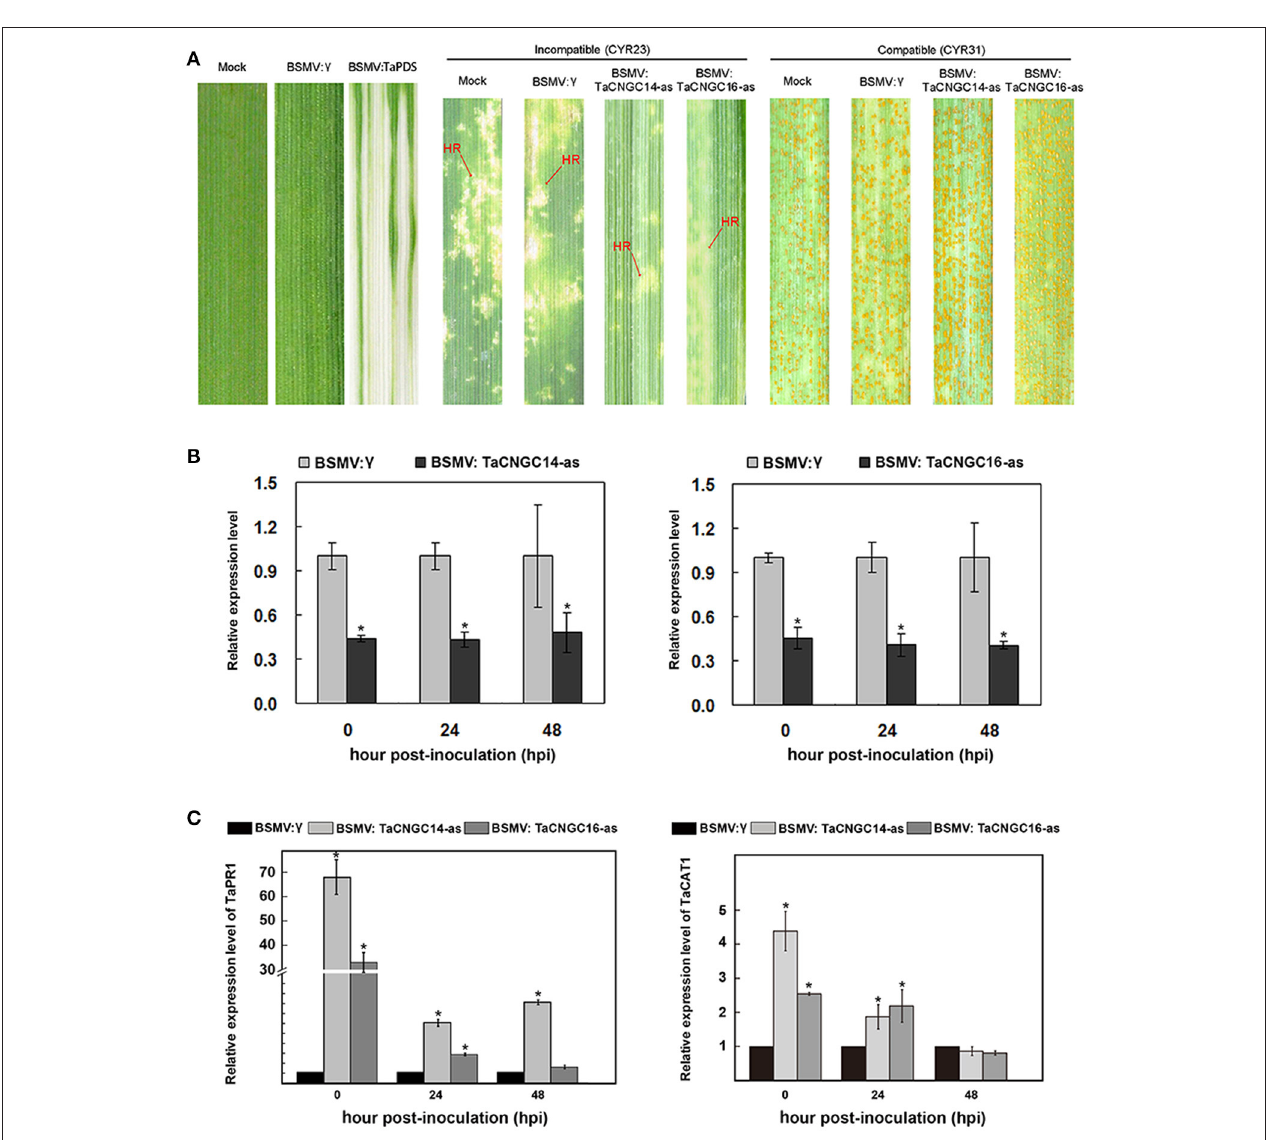
FIGURE 6 | Functional characterization of TaCNGC14 and TaCNGC16 by BSMV-HIGS. (A) BSMV:TaPDS showed photobleaching at 10 dpi; Mock: wheat leaves treated with 1X Fes buffer. Shown are the fourth leaves inoculated with of the avirulent race CYR23, or the virulent race CYR31. Leaves were photographed at 14 dpi. (B) Silencing efficiency assessment of two TaCNGCs in the fourth leaves of TaCNGCs-knockdown plants inoculated with avirulent race Pst CYR23. (C) Transcriptional changes in PR1 genes and CAT1 in TaCNGCs-knockdown wheat seedlings. Three biological replicates were calculated by the comparative threshold (2 − 11 CT ) method. Asterisks represent significant differences at the same time point by Tukey’s HSD test ( P < 0.05). HR, hypersensitive